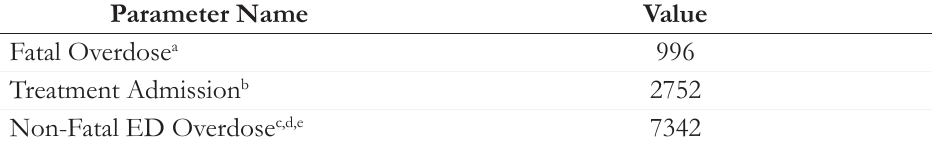
Table 1. Individual Multiplier Model Endpoint Data for Cincinnati